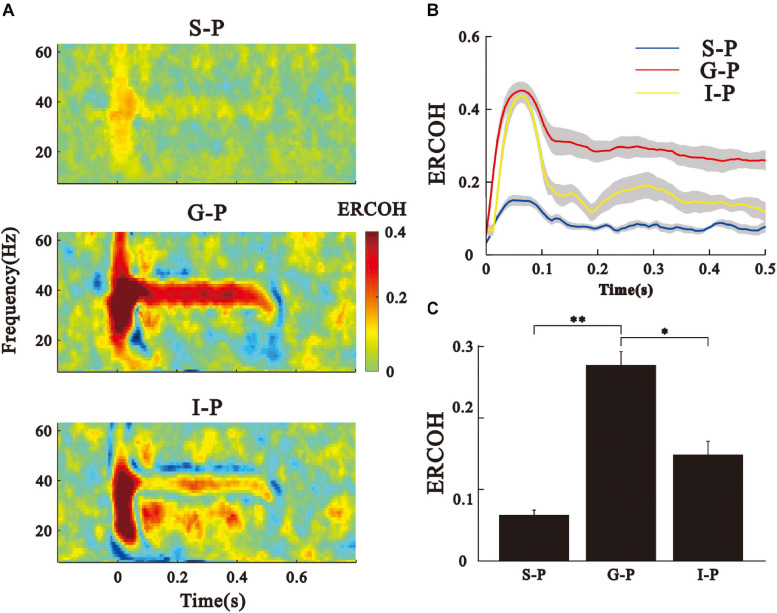
ERCOH between the LFPs of pial surface and deep layers. (A) Spectral-temporal function of ERCOH between the P layer and other layers. (B) Time function of ERCOH (35–45 Hz) of the different pairs of layers averaged over eight animals. Sold line represents mean, shade area represents SE. (C) Bar graph shows the mean and SE of ERCOH values averaged across the 35–45 Hz frequency and 0.2–0.5 s post-stimulus time window. ∗∗p < 0.01, ∗p < 0.05, Kruskal–Wallis test followed by Tukey’s multiple comparison.